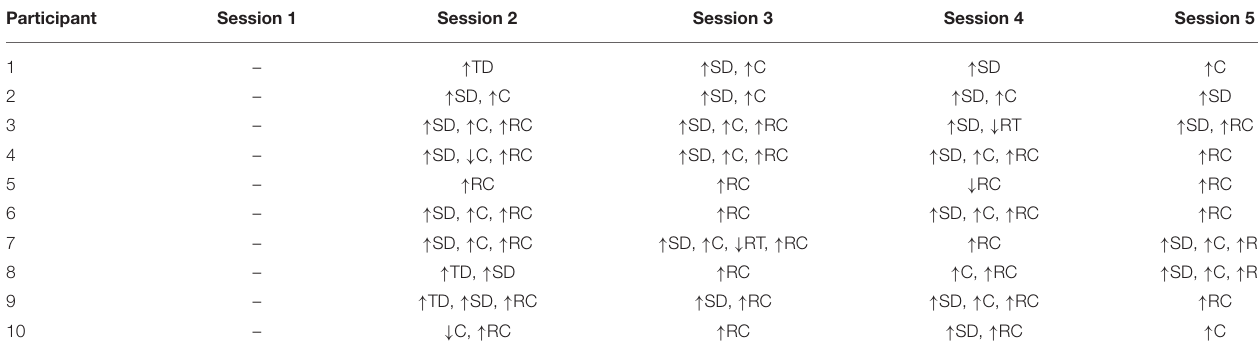
TABLE 2 | In-person jumping rope training progression.